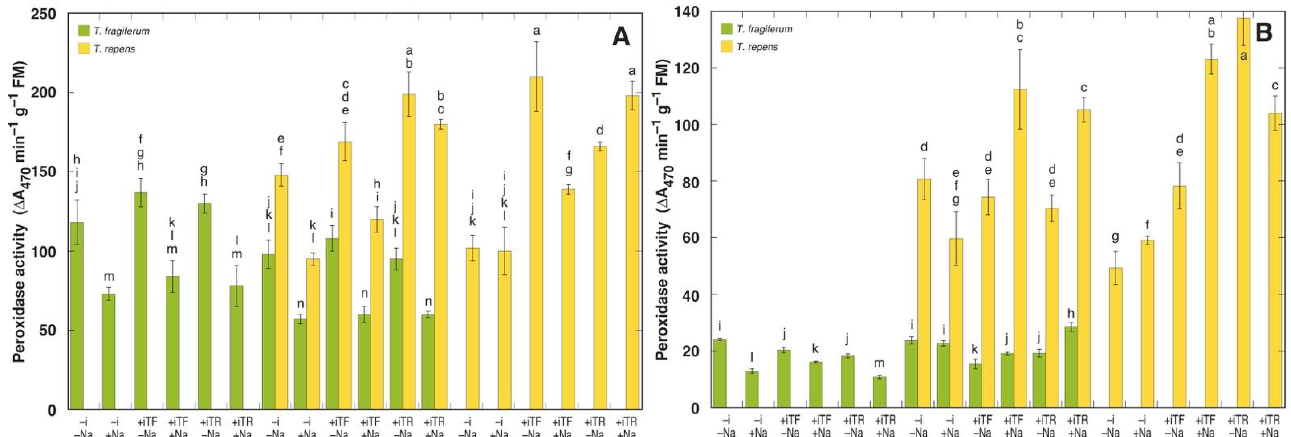
Figure 5. Peroxidase activity in leaves ( A ) and leaf petioles ( B ) of T. fragiferum and T. repens at the harvest. Data are the means from three replicates ± SE, the results are expressed on fresh mass basis. – i, without inoculant; +iTF, with inoculant isolated from T. fragiferum ; +iTR, with inoculant isolated from T. repens ; − Na, no NaCl added; +Na, NaCl up to 400 mM. Different letters indicate significant differences between the treatments ( p < 0.05).